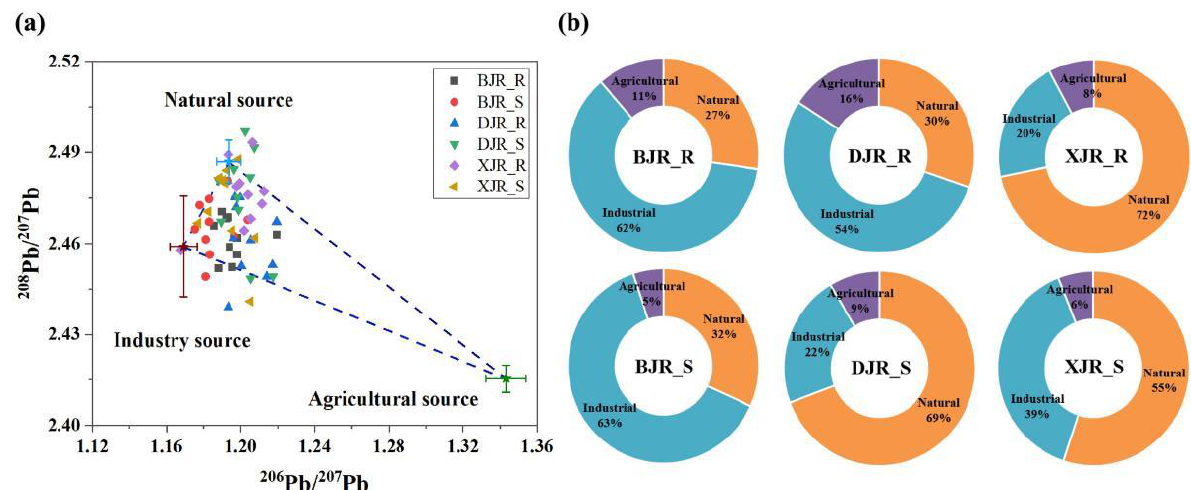
Figure 6. Results of input sources in three reaches based on Pb isotope identification. ( a ) means the 206 Pb/ 207 Pb and 208 Pb/ 207 Pb ratios in the riparian soils and sediments of the three reaches, and ( b ) means the relative contributions of industrial, agricultural, and natural sources in the riparian soils and sediments of the three reaches, respectively.